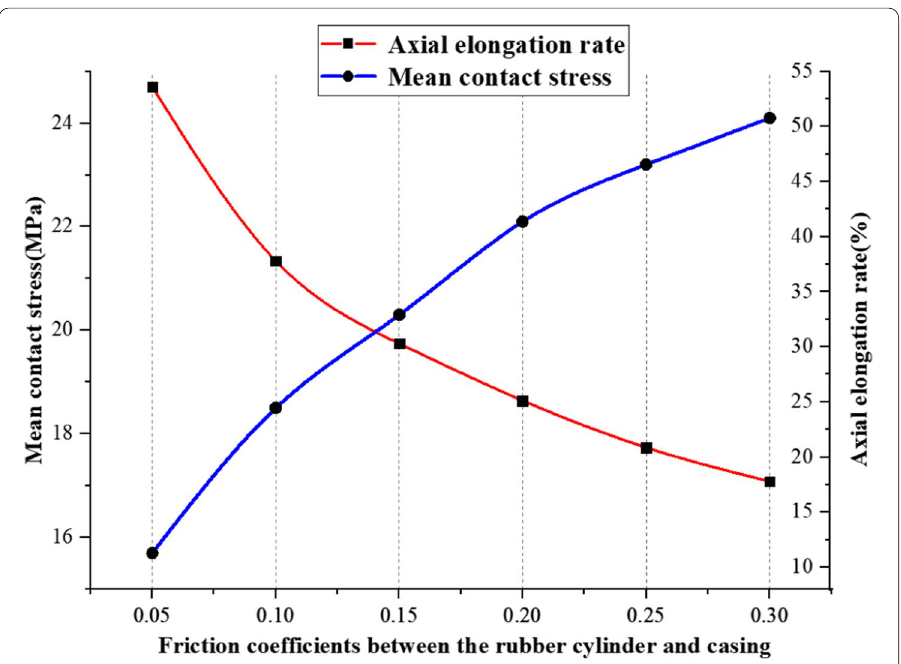
Fig. 11 The relationship between axial elongation rate, average contact stress and friction